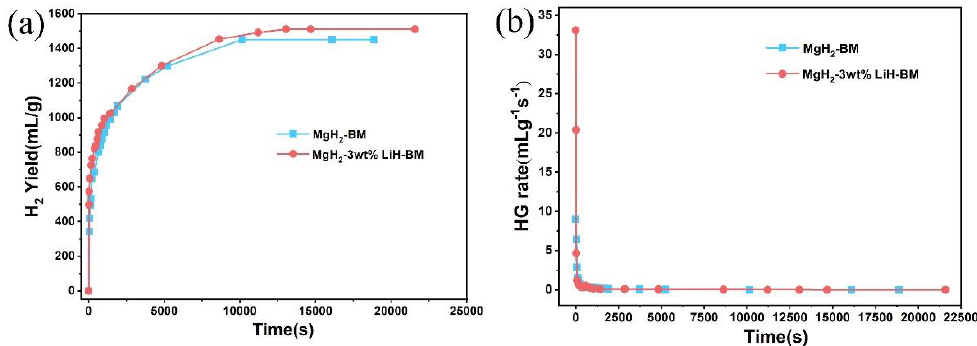
Figure 10. ( a ) Hydrogen generation curves and ( b ) hydrogen generation rate of the MgH 2 and MgH 2 -3 wt % LiH-BM in water at 60 °C.